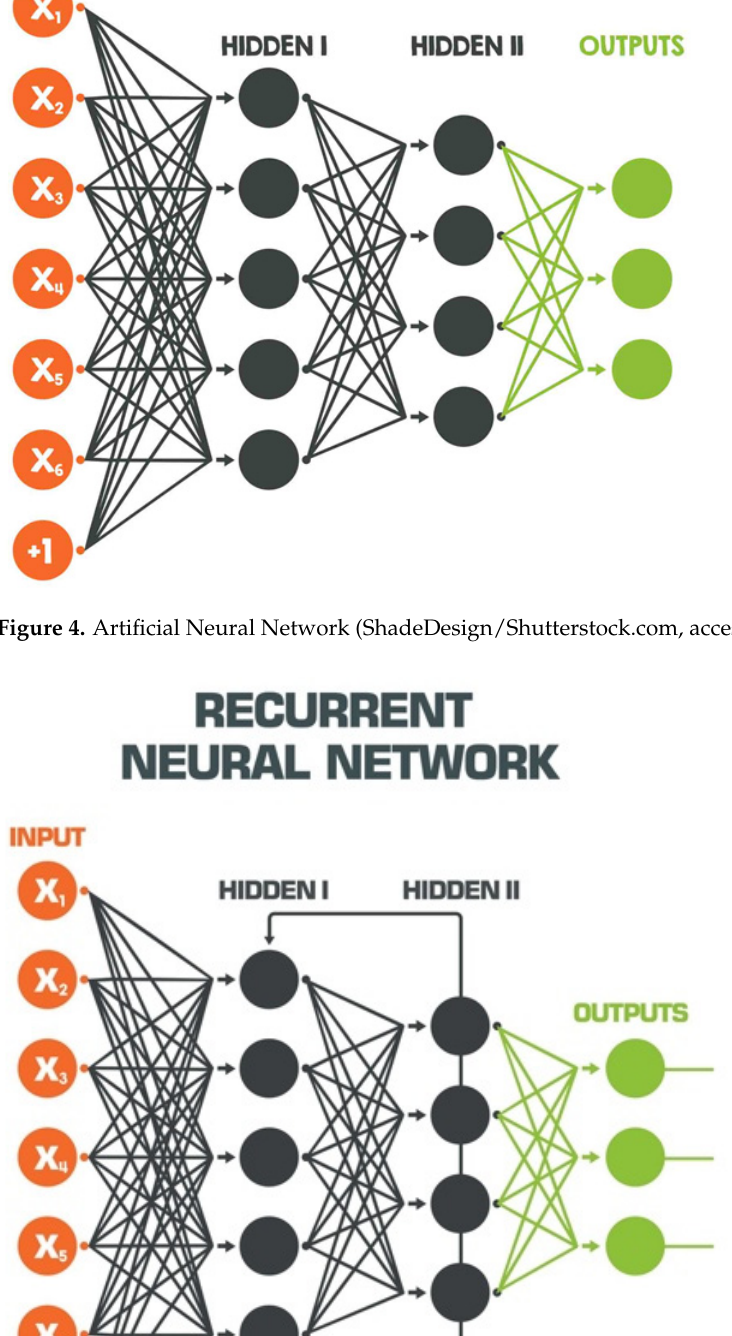
Figure 4. Artificial Neural Network (ShadeDesign/Shutterstock.com, accessed on 27 April 2022).